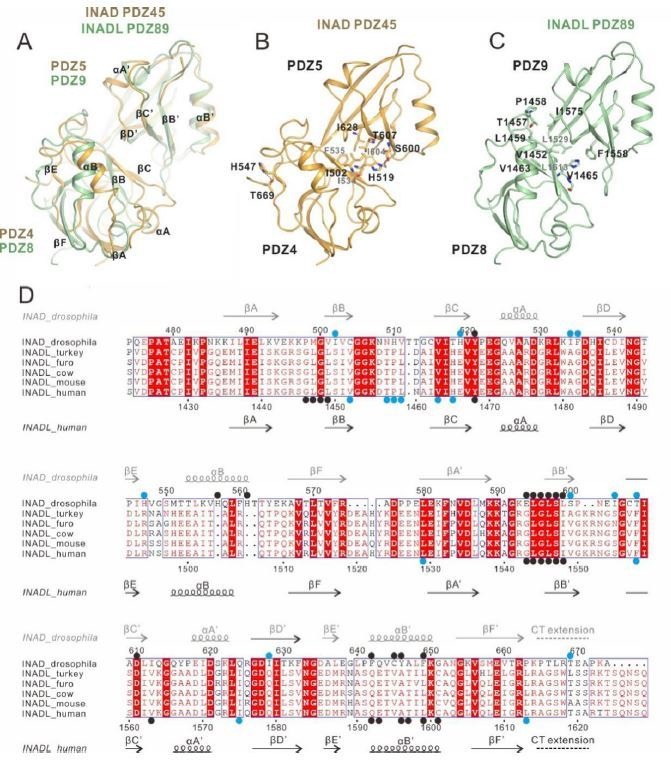
Comparison of the inter-PDZ domain packing of the INAD PDZ45 and INADL PDZ89 tandems in the two complex structures.(A) Superposition of INAD PDZ45 (in yellow) and INADL PDZ89 (in green). (B) Ribbon combined stick representation showing the domain packing interface of INAD PDZ45. (C) Ribbon combined stick representation showing the domain packing interface of INADL PDZ89. (D) Multiple sequence alignment of INAD PDZ45 and INADL PDZ89 from Drosophila to human by ClusterW and ESpript (espript.ibcp.fr/ESPript/ESPript/). The key residues involved in the PDZ domain coupling are highlighted in blue dots. The key residues of PDZ domains involved in the NORPA/PLCβ4 interaction interface are highlighted by black dots.